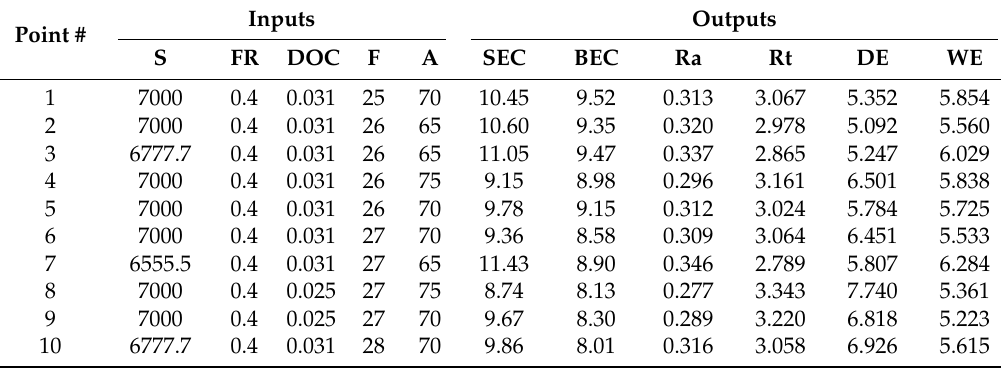
Figure 19. A parallel coordinate chart for the analysis of RUM parameters for optimal points. Table 6. Optimal points for all responses.